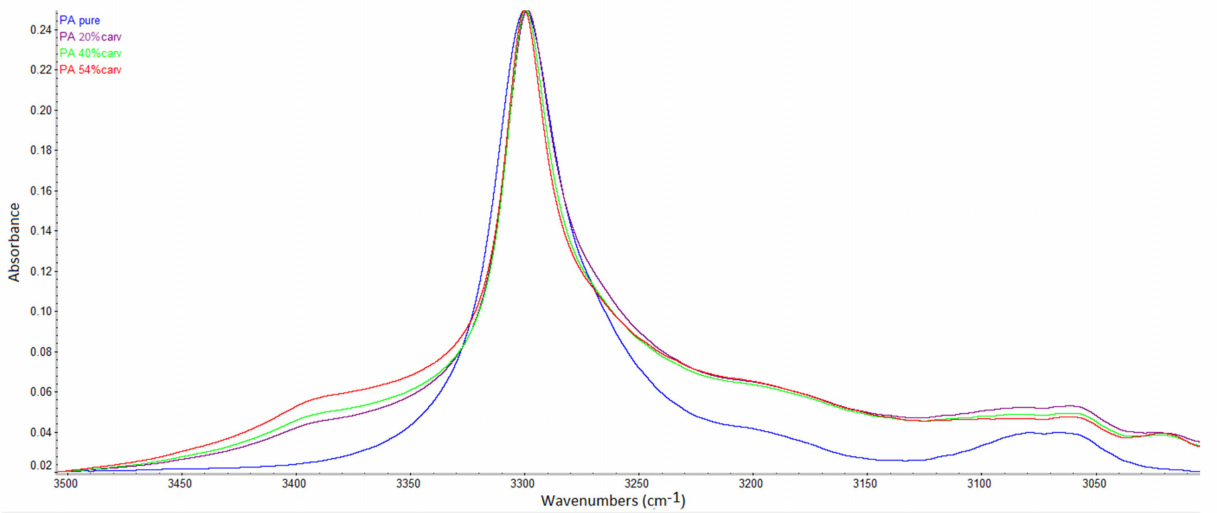
Figure A8. N–H stretching vibration bands in neat and carvacrol-impregnated polyamide membranes.